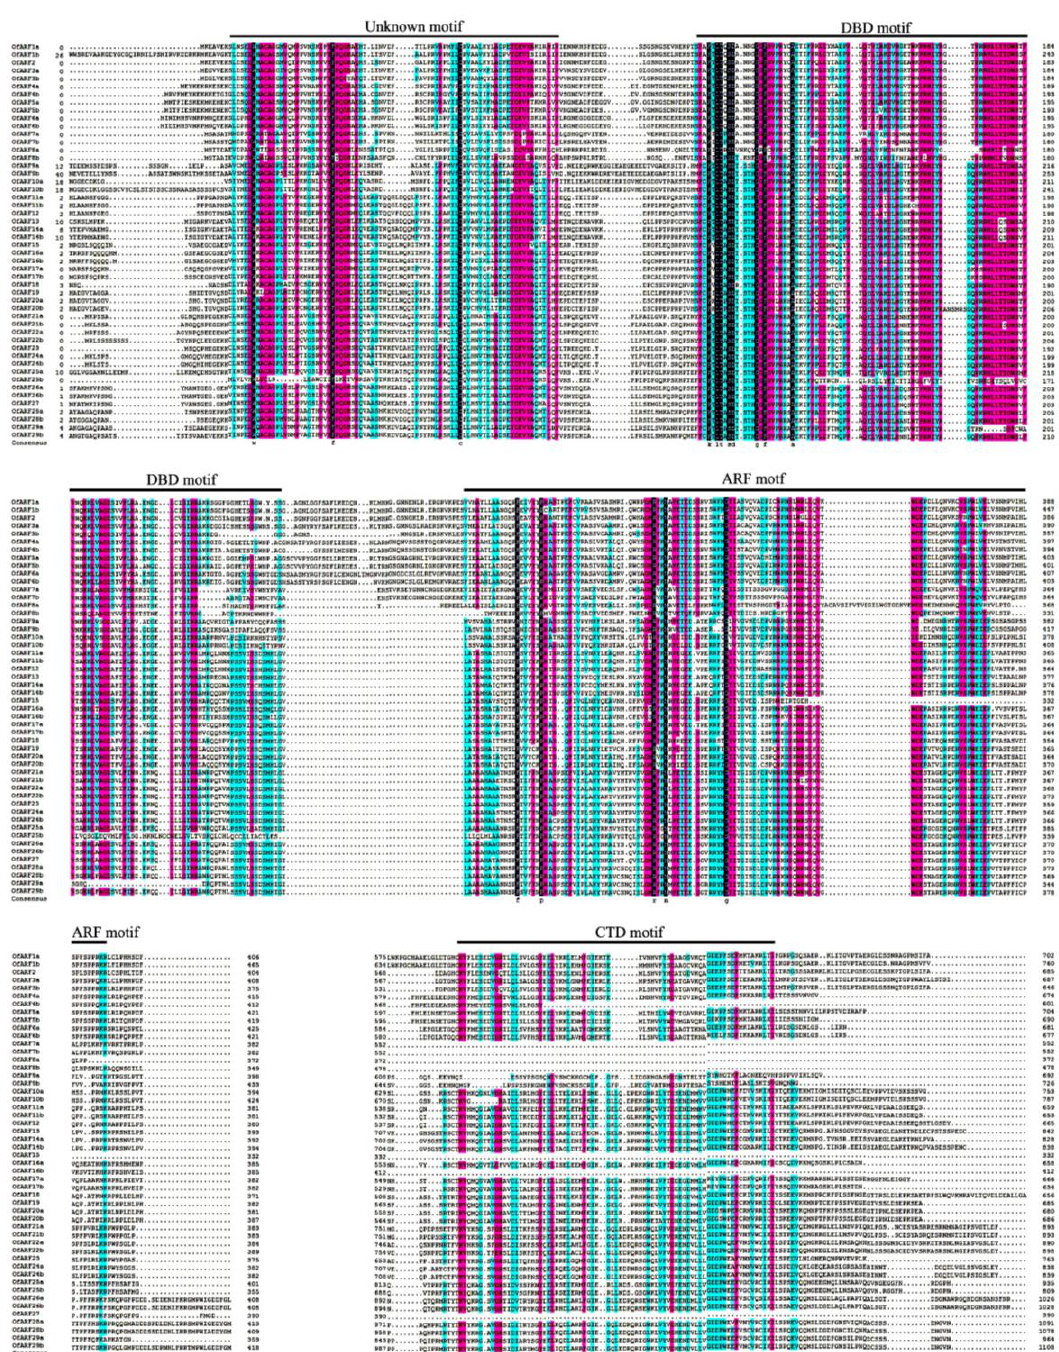
Figure 4. Multiple sequence alignment of the Osmanthus fragrans auxin response factor (OfARF) proteins obtained with DNAMAN 8.0. Conserved domains of OfARF proteins are marked by the overline.